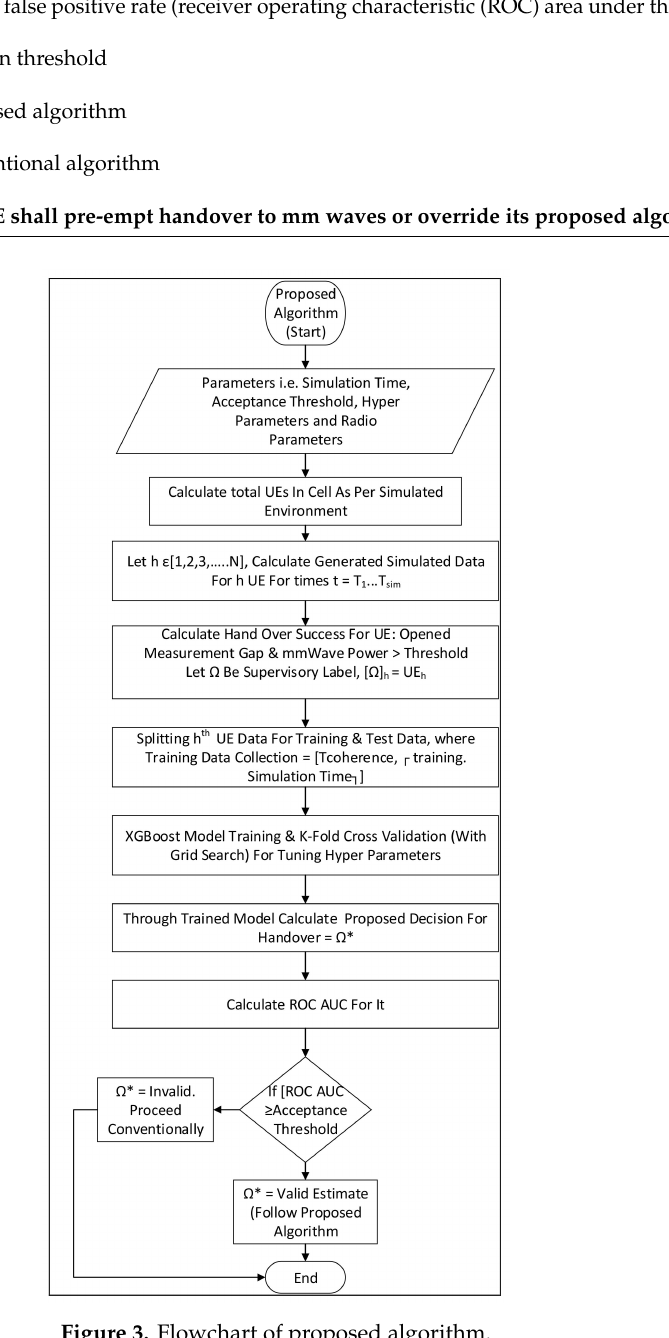
Figure 3. Flowchart of proposed